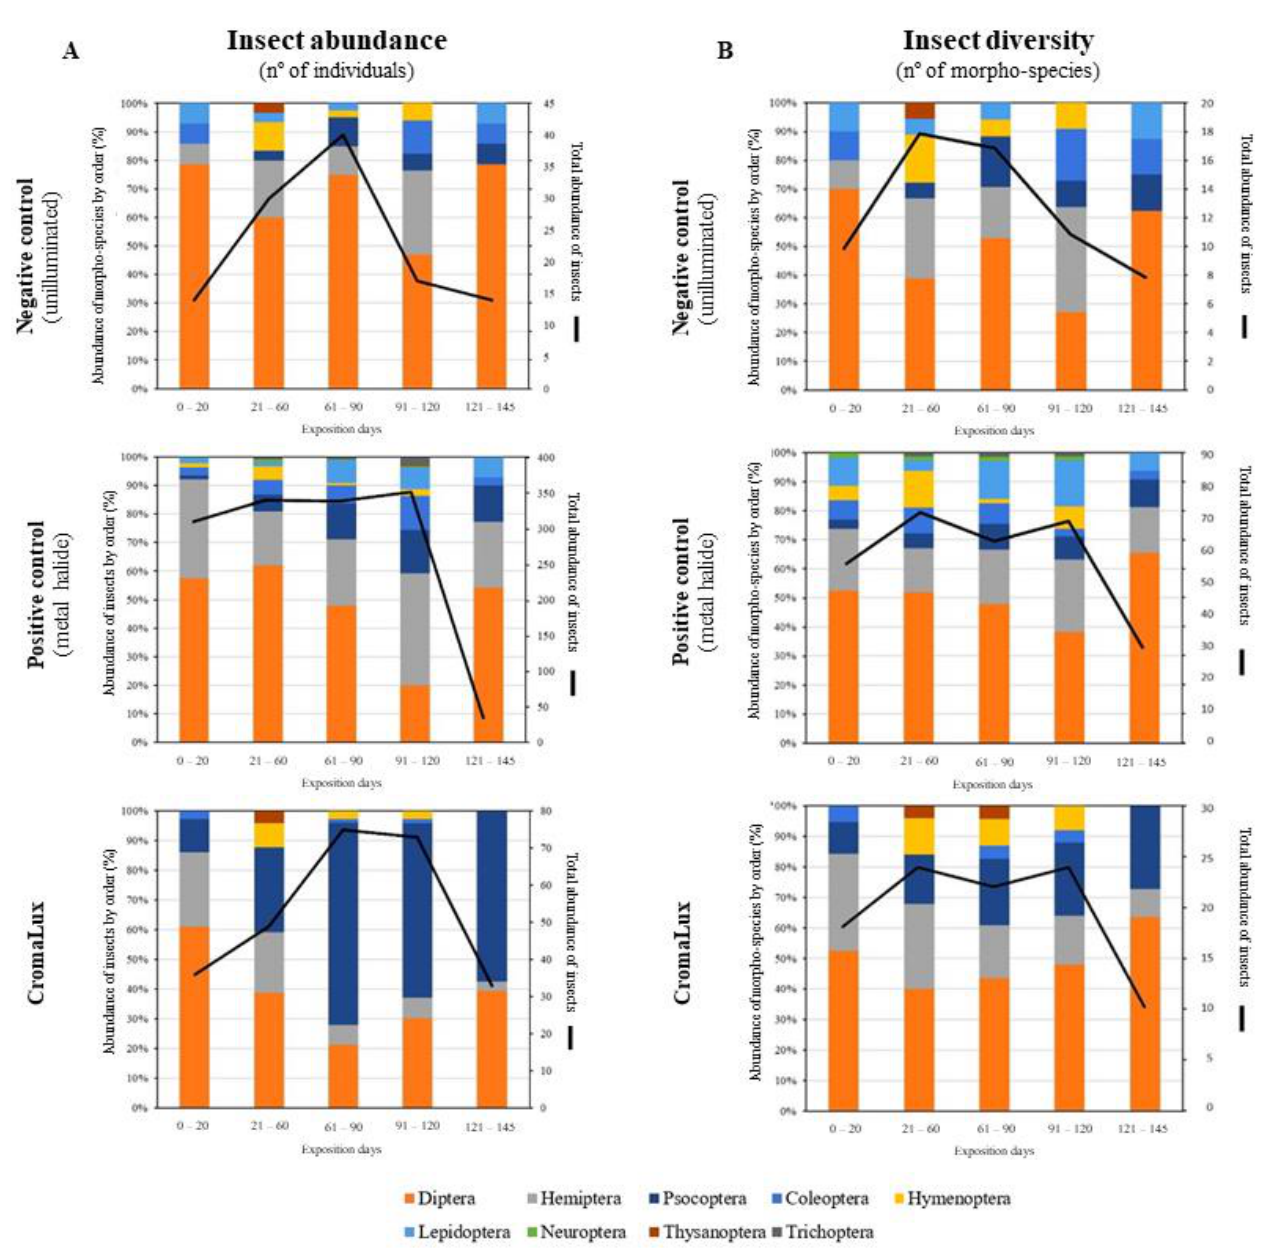
Figure 7. Temporal succession of insect abundance ( A ) and insect diversity ( B ) corresponding to the three lighting conditions during the five study periods (see Table 1). The black line represents the total abundance of insects ( A ) and of insect morphospecies ( B ). The numbers in ( B ) indicate the Shannon–Wiener index for each time